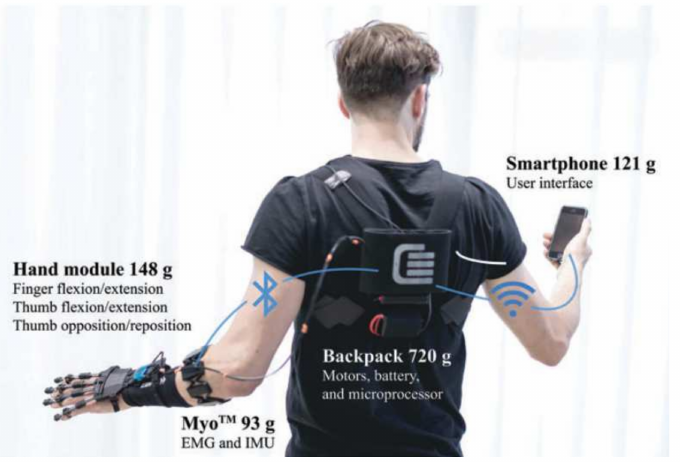
Figure 8. Close-up view of the RELab tenoexo